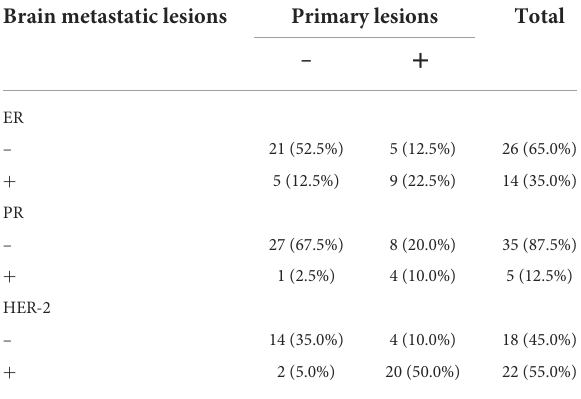
TABLE 2 Summary of receptor conversion between the primary lesions and brain metastatic lesions. Brain metastatic lesions